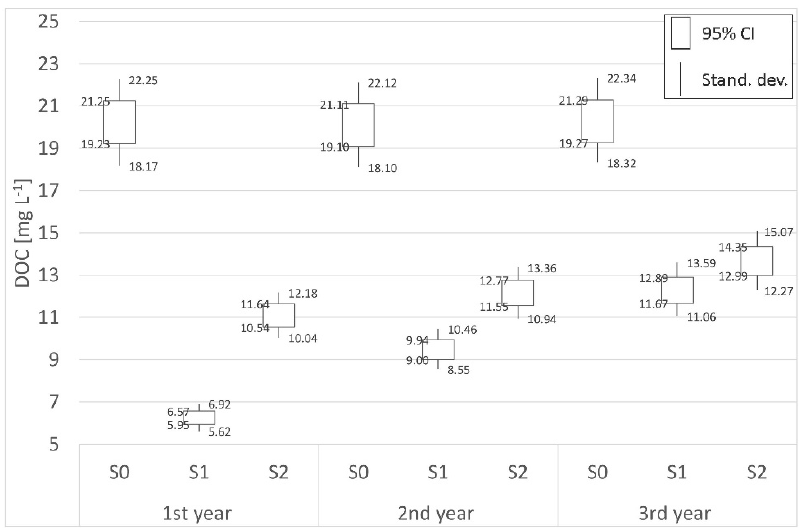
Figure 5. The concentrations of DOC in groundwater under shelterbelt soils.